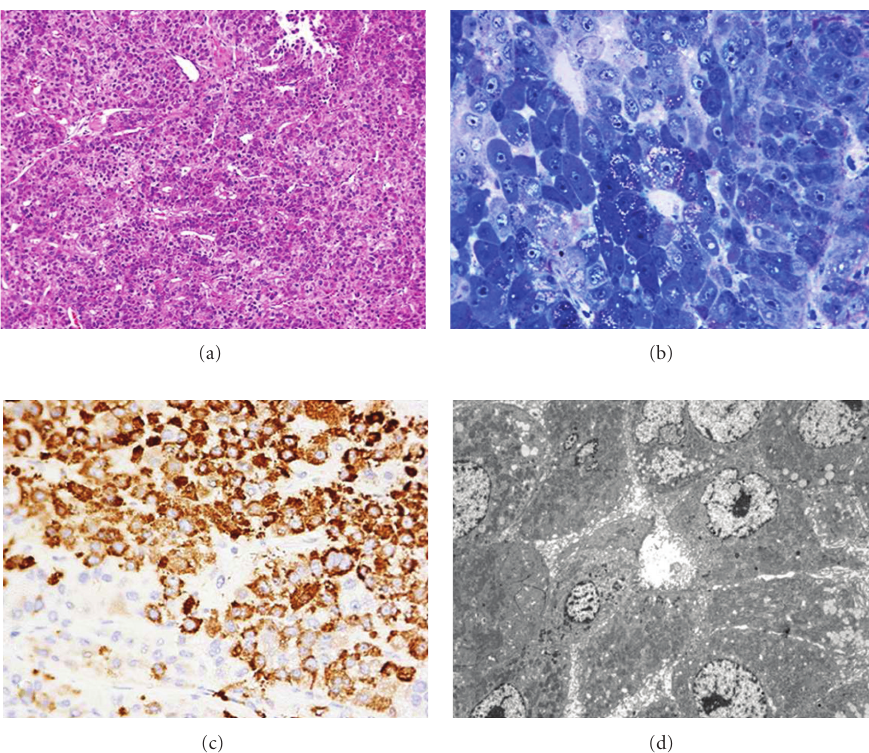
Figure 2: (a) The tumor is composed of cords of cells resembling hepatocytes surrounded by a looser hypocellular fibrous stroma containing prominent sinusoidal vessels. (E.E, 100x). (b) Semithin section: polygonal cells in trabecular pattern, with large nuclei and prominent nucleoli and many intracytoplasmic small vesicles (Polychr. sec. Tolivia, 400x). (c) The neoplastic cells showed strong and di ff use immunoreactivity for OCH1E5. (I.I.C., 400x). (d) Electron microscopic appearance: malignant hepatocytes with numerous mitochondria, abundant glycogen, and large nuclei with prominent nucleoli. Bile canaliculi with stubby microvilli and cell junctions were also evident (TEM,